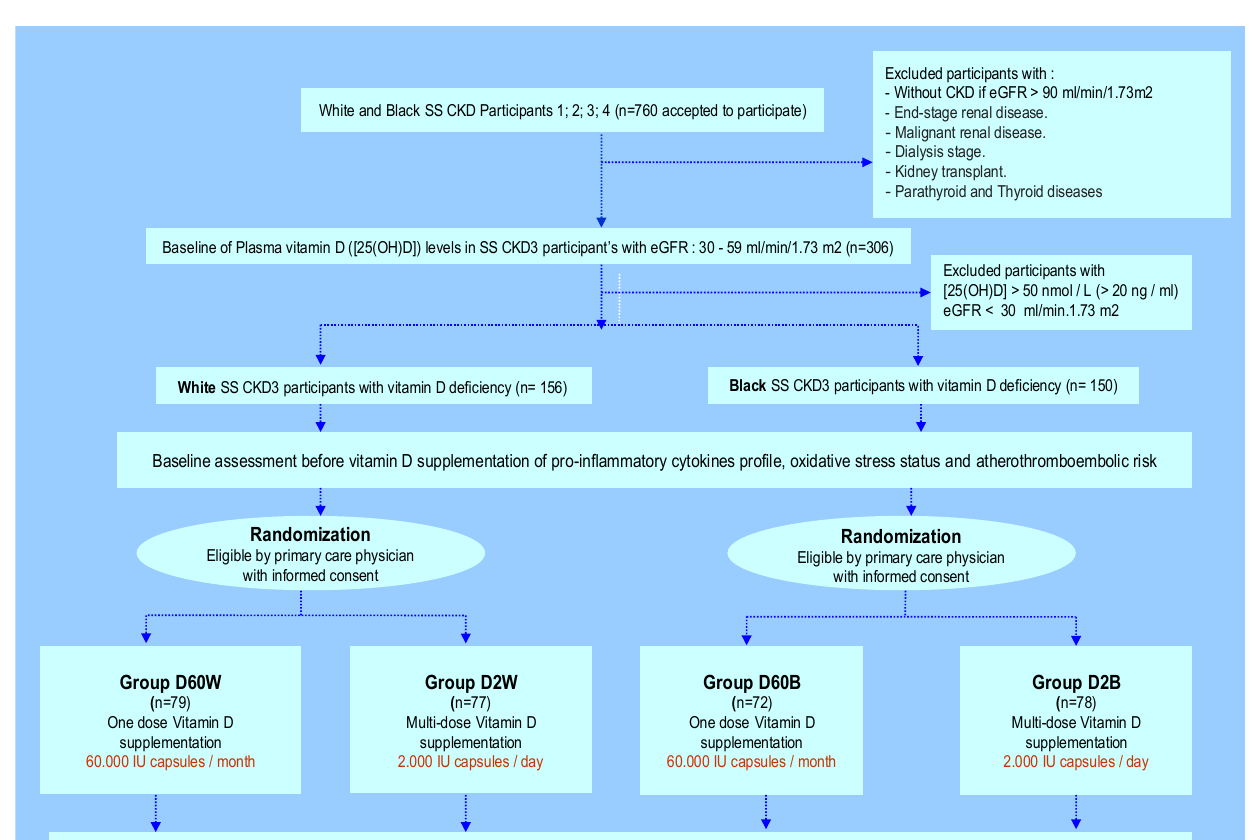
Revaluation of pro-inflammatory cytokines profile, oxidative stress status and atherothromboembolic risk after 24 and 36 weeks of vitamin D supplementation